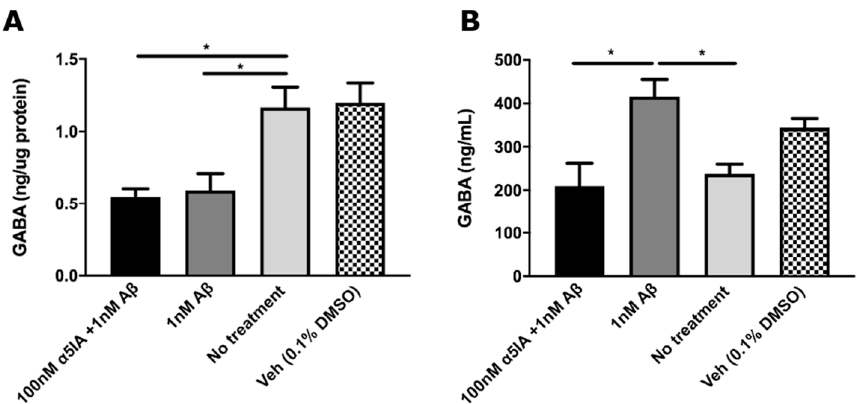
Figure 4. Intracellular ( A ) and extracellular ( B ) GABA concentrations in mouse primary hippocampal cultures 5 days after treatment with A β 1–42 and α 5IA + A β 1-42 as measured by ELISA. Intracellular GABA levels were normalized to protein content measured using DC assay. Extracellular refers to GABA in the culture medium. Data is expressed as mean ± SEM. * p < 0.05, One-way ANOVA with Bonferroni’s post hoc test, n = 3 for each experimental group with triplicate measurements.